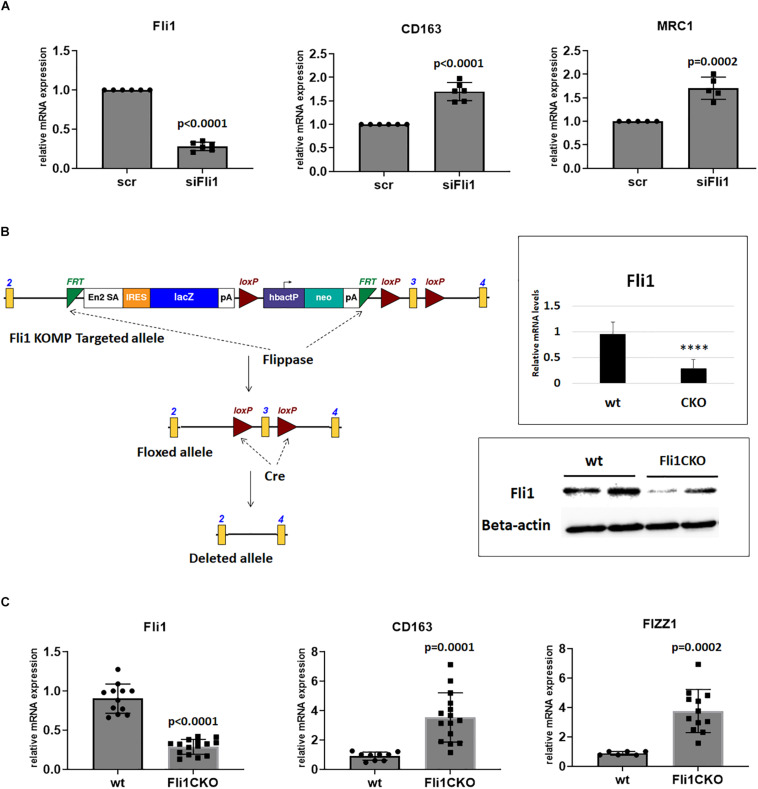
Expression of the A-Mø markers is high in Fli1 deficient cells. (A) Human THP1 cells were treated with Fli1 and scr siRNA and then 24 h later with 10 ng PMA for 4 h, then mRNA extracted after total 48 h, and relative mRNA levels of CD163 and MRC1 were quantified by RT-PCR (n = 4). Mean ± SD. (B) Generation of myeloid specific Fli1 knockout mice (Fli1flox/floxLysMCre+/+, Fli1 CKO). Schematic outline of the Fli1 KOMP targeting construct and Fli1 floxed allele. Neo: neomycin resistance gene. Flippase: FLP recombinase to remove the Neo cassette. The structures of the mutant allele after in vivo Cre-mediated recombination in myeloid cells lacks exon 3. Upper right panel shows relative mRNA levels of Fli1 in peritoneal macrophages isolated from wt and Fli1CKO mice, and bottom right panel shows protein levels of Fli1 in wt and Fli1CKO. Two mice were pooled for protein levels in each group. Beta actin was used as control for loading. (C) Peritoneal macrophages were collected from wt and Fli1 CKO mice and mRNA extracted and RT-PCR used to quantify levels of CD163, and FIZZ1. Individual mice used for each sample. ****p < 0.0001.